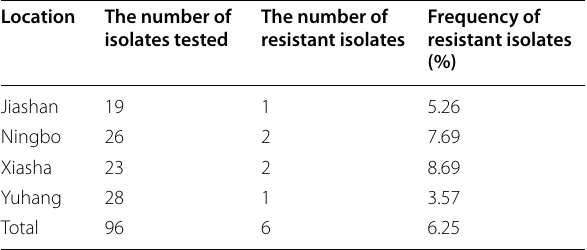
Table 1 Frequency and distribution of FluR isolates from different districts in Zhejiang Province,